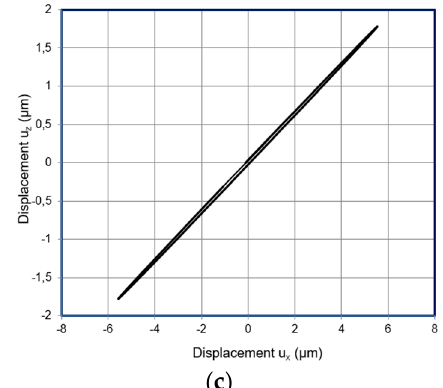
Figure 8. Contact point vibration trajectories of the ring type actuator. ( a ) 3 electrodes; ( b ) 6 electrodes; ( c ) 9 electrodes.